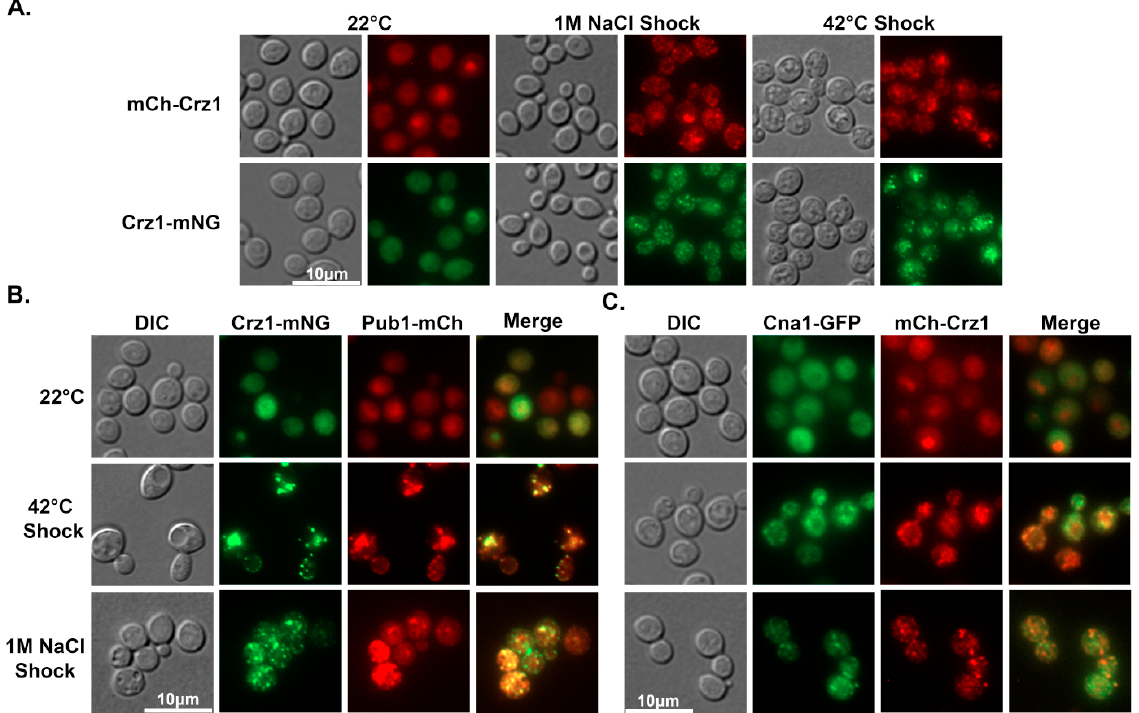
Figure 2. Crz1 co-localizes to stress granules with Pub1 and calcineurin in response to heat or salt shock. ( A ) mCherry-Crz1- or Crz1-mNeonGreen-expressing cells were incubated at 22 °C overnight and fluorescence was observed. To test the effects of salt and heat shock, cells were suspended in 1 M NaCl or exposed to 42 ◦ C for 15–20 min prior to microscopic examination. ( B ) The same procedure was done with cells expressing both Crz1-mNeonGreen and Pub1-mCherry and ( C ) cells expressing both mCherry-Crz1 and Cna1-GFP. The scale of all images in each panel is the